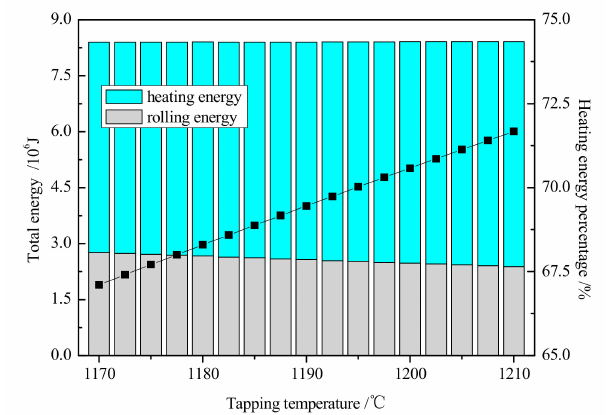
Figure 6. The influence of tapping temperature on heating energy and rolling